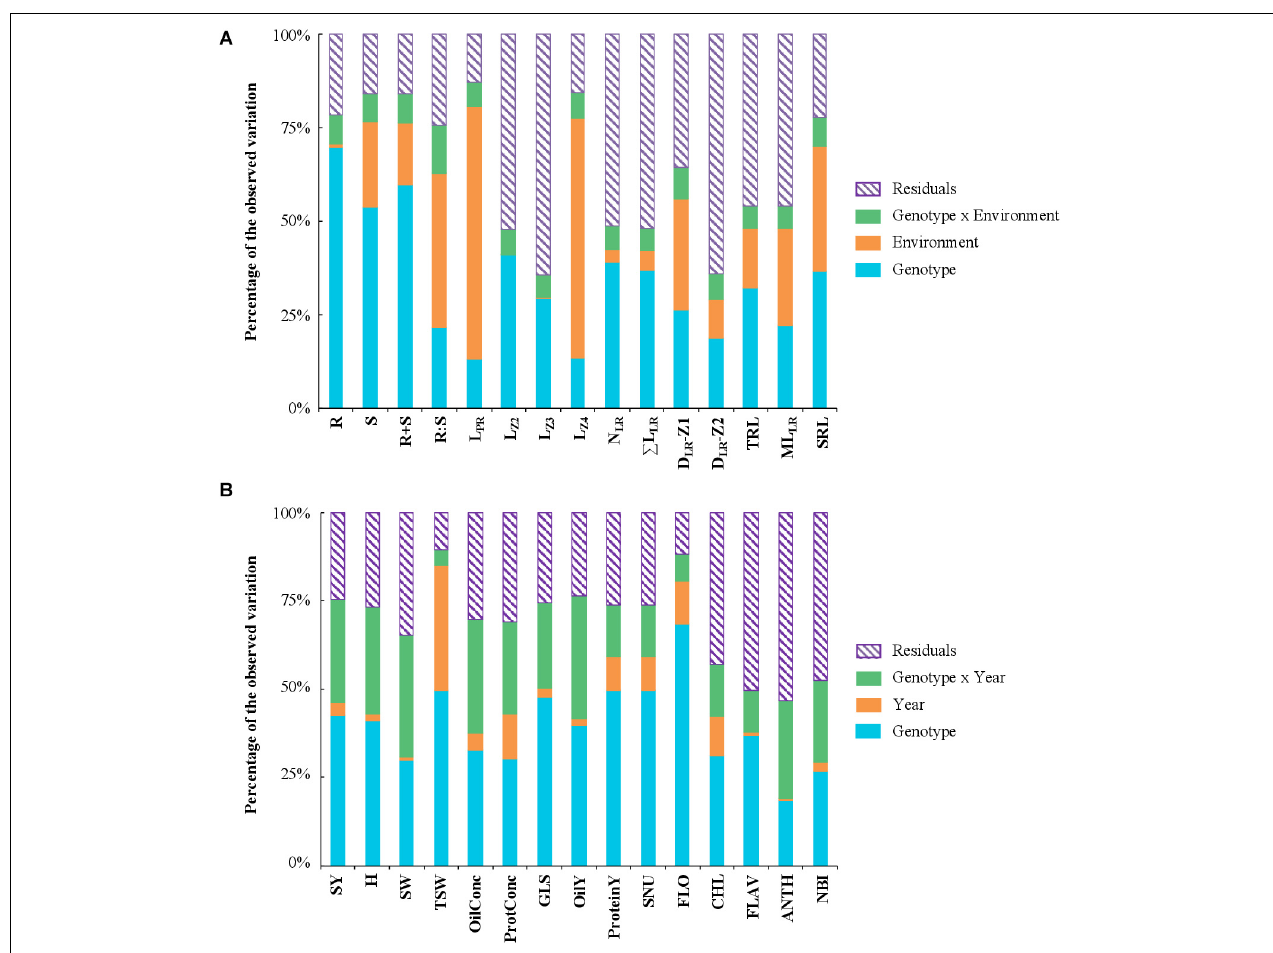
FIGURE 3 | Variance component analysis with phenotypic traits measured in 28 winter oilseed rape cultivars. The histograms show the schematic ANOVA representation for traits measured in hydroponic (A) or in field (B) conditions. The components of phenotypic variance are (A) the genotype/cultivar, environment/nutrition, and interaction (genotype × environment) and residuals as a percentage of the observed variation, and (B) genotype/cultivar, year and interaction (genotype × year) and residuals as a percentage of the observed variation. Traits are defined in Tables 1 , 2